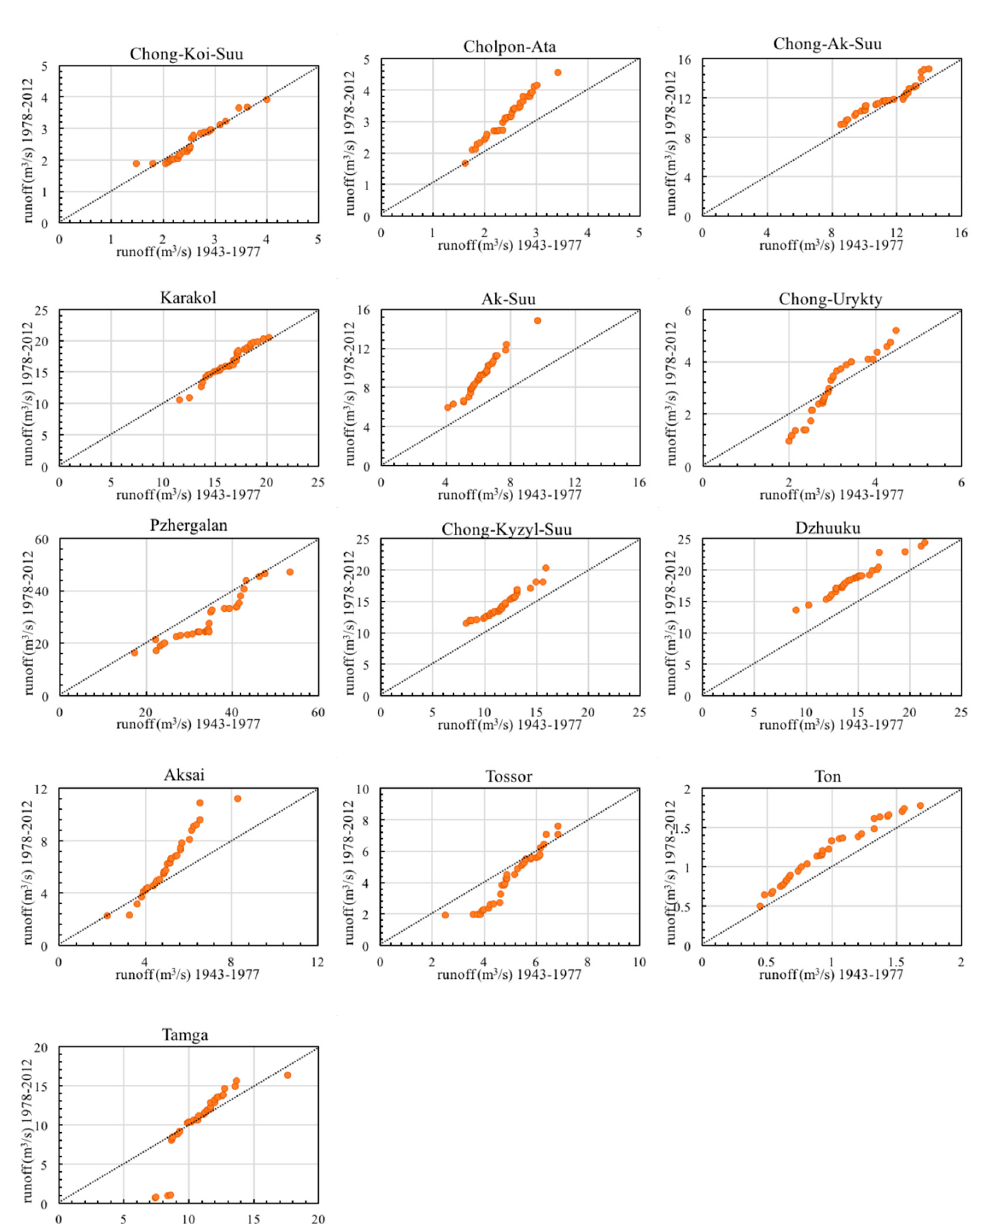
Figure 5. Analysis of the ITA for summer river runoff at 13